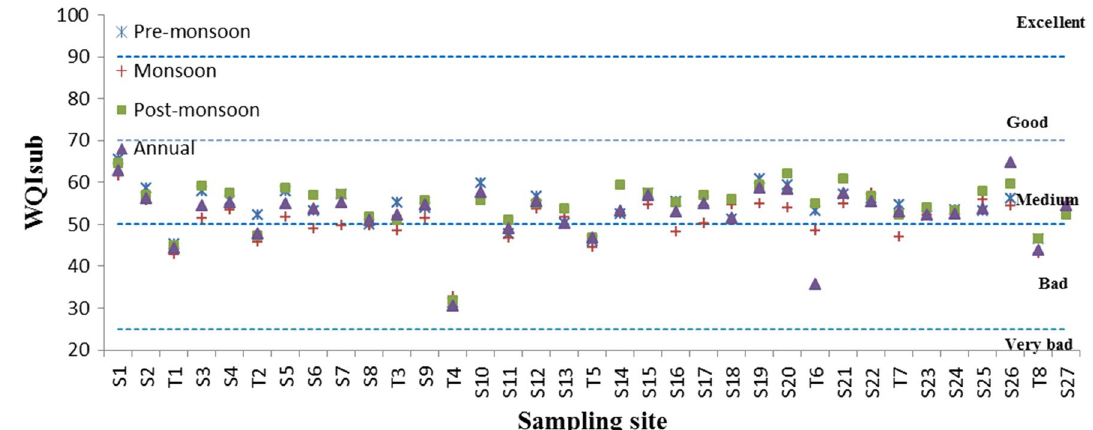
Fig. 5 Spatial and temporal variations of WQI